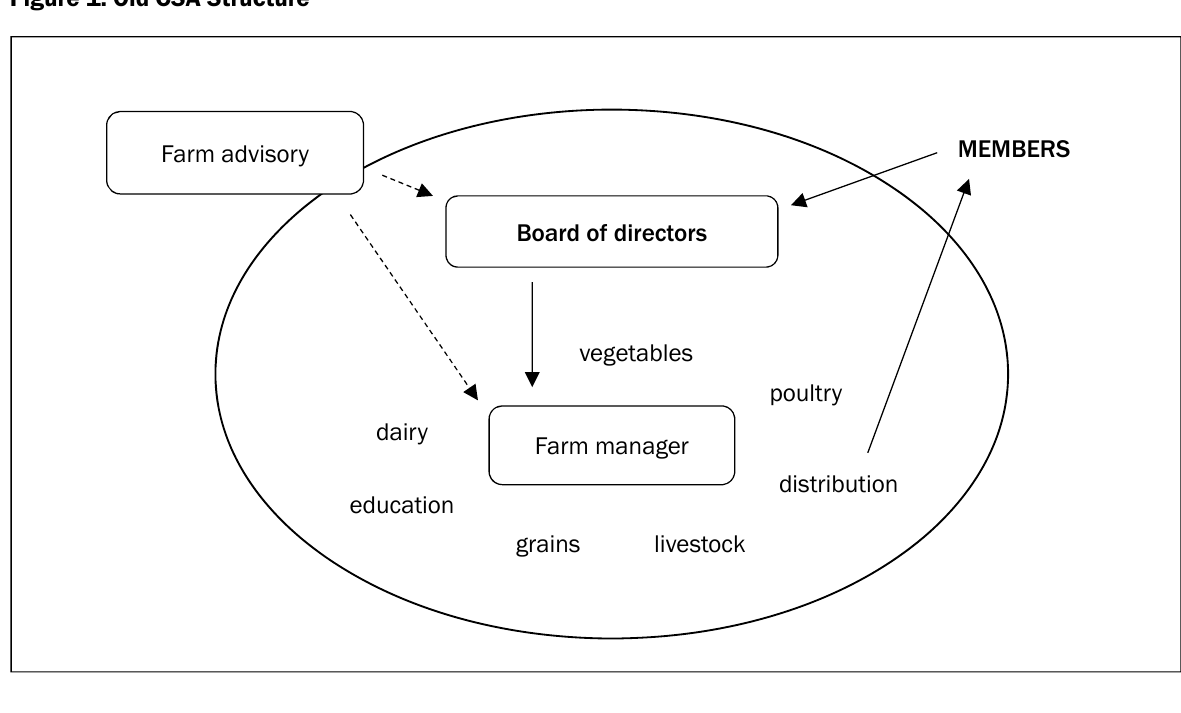
Figure 2. Revised CSA